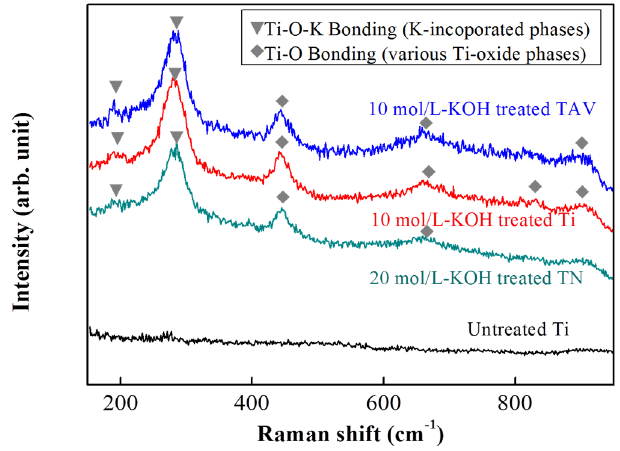
Figure 3. Raman spectra of the surfaces of 10 mol/L-KOH-treated Ti, 10 mol/L-KOH-treated TAV and 20 mol/L-KOH-treated TN and untreated substrates. Compared with untreated substrates, Ti–O–K bonds were clearly observed in all KOH-treated Ti, TAV and TN substrates. The general trend for structural changes is remarkably similar within the same morphology, indicating that the TiO 2 phase, which is made of Ti–O bonds, and K-incorporated Ti–Oxide phase, made of Ti–O–K bonds, are generated by rearranging the atoms in the Ti metal. Note that the Ti–O–K bonds peaks were detected in the region <400 cm − 1 and the Ti–O bonds peaks were detected in the region 400–1000 cm − 1